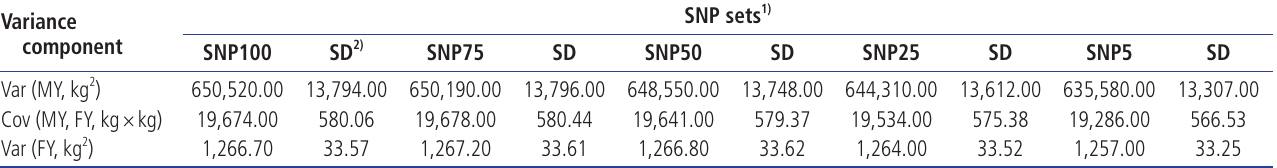
Table 4. Phenotypic variances and covariances for MY and FY estimated with five SNP sets using genomic-polygenic models Variance